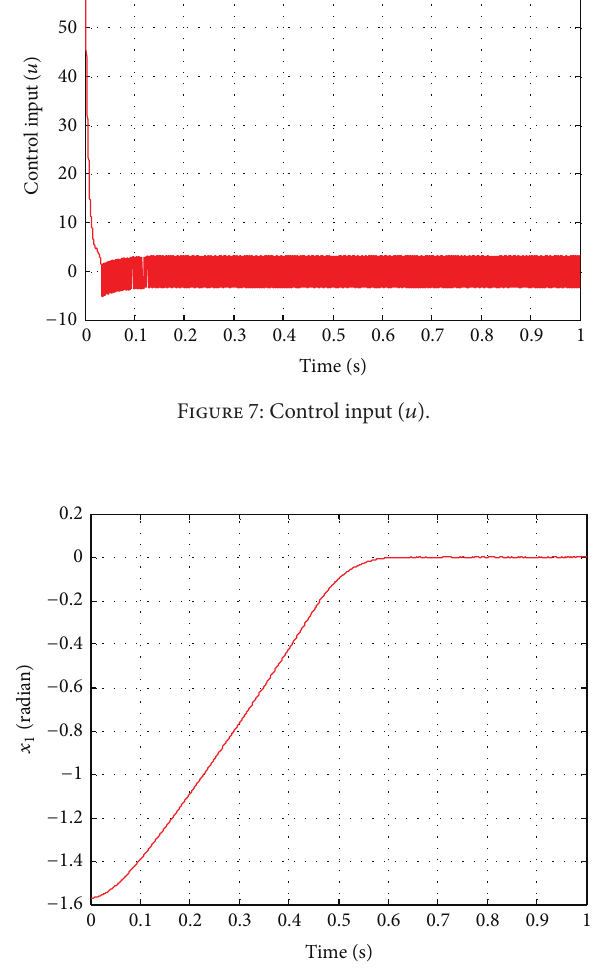
Figure 8: Output angle ( 𝑥 ).